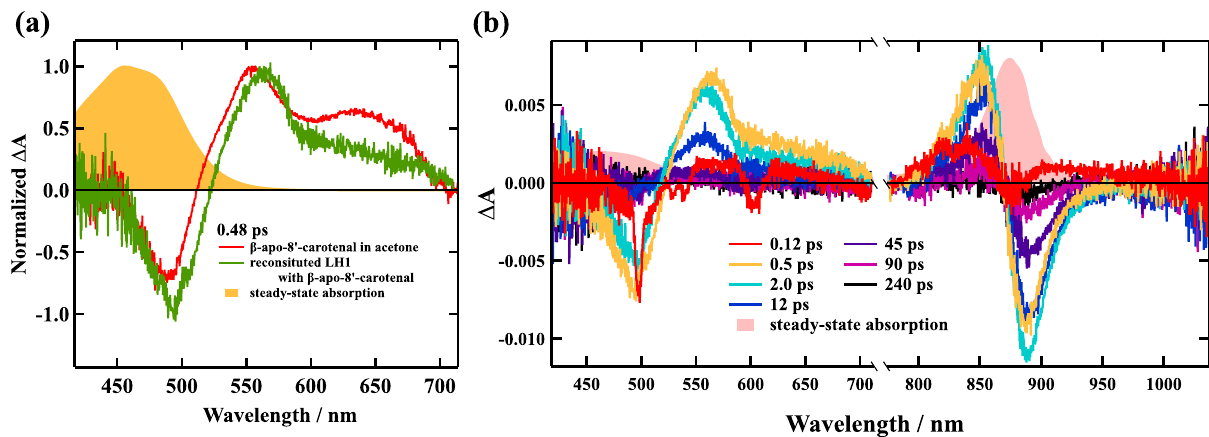
Fig. 4 Femtosecond time-resolved absorption spectra of β -apo-8 ′ -carotenal in acetone and Re β apo. a Femtosecond time-resolved absorption spectra of β -apo-8 ′ -carotenal in acetone (solid red line) and in Re β apo (solid green line) recorded at 0.48 ps after excitation. b Femtosecond time- resolved absorption spectra of Re β apo in 20 mM Tris-HCl buffer (pH 8.0) + 0.58% β -OG at room temperature following excitation up to the S 2 state of β -apo-8 ′ -carotenal. The steady-state absorption spectra of β -apo-8 ′ -carotenal in acetone and that of Re β apo are also shown for comparison. The excitation laser pulse was 490 nm for β -apo-8 ′ -carotenal in acetone and 500 nm for Re β apo. All the measurements were carried out at room temperature.